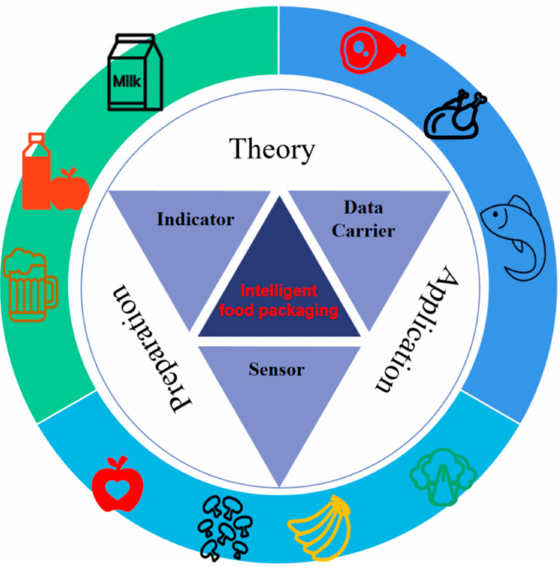
Figure 8. Framework of intelligent food packaging indicators for monitoring food